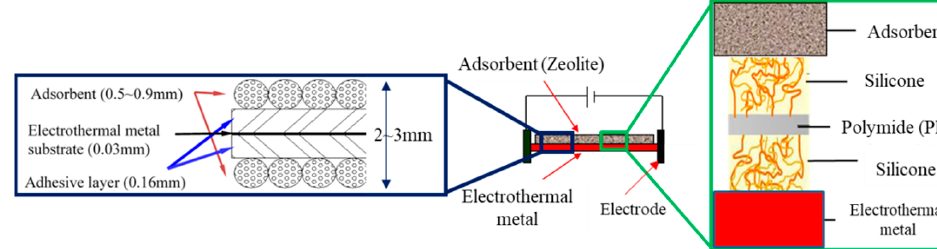
Figure 8. Special adhesive in an ETAU.